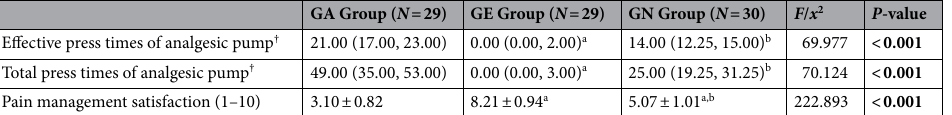
Table 2. Comparison of the press times of the analgesic pump and pain management satisfaction. a Compared with the GA group, P < 0.05; b Compared with the GE group, P < 0.05. † The index did not conform to the normal distribution. The index is expressed as the median and interquartile range, and the rank sum test was used for comparison between groups. Effective press times of analgesic pump: in order to ensure the safety of patients, there is a locking time after pressing the analgesic pump to avoid excessive drug entering the body. Pressing beyond the locking time is defined as effective pressing. Significant values are in bold.